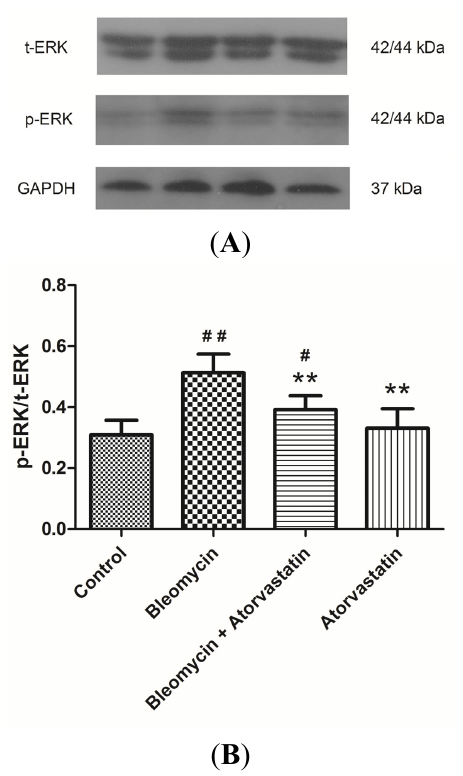
Figure 7. Effects of atorvastatin on the phosphatidylinositol ERK signaling in the lungs of bleomycin-induced pulmonary fibrosis rats. The increased levels of phosphor-ERK were significantly inhibited by administration of atorvastatin. ( A ) Representative blots of phosphor-ERK and total ERK are shown and protein size is expressed in kDa; and ( B ) Densitometric quantification data are expressed as the intensity ratio of target proteins to GAPDH (mean ± SD, n = 5). # p < 0.05 and ## p < 0.01 vs. the control group, respectively; ** p < 0.01 vs. the bleomycin